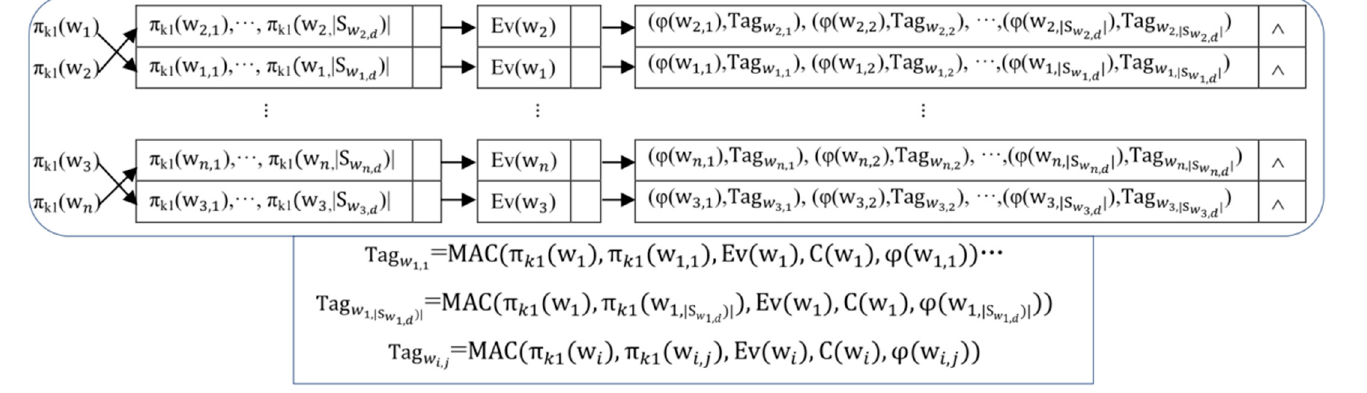
Figure 2. Index structure.